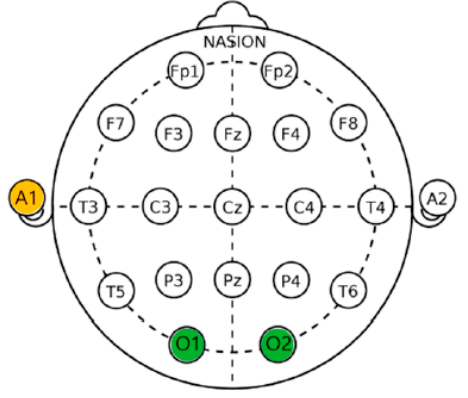
Figure 4. International electrode arrangement